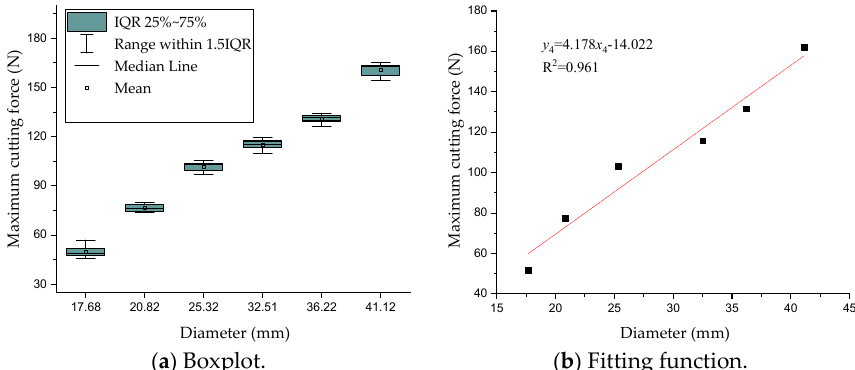
Figure 10. Boxplot and fitting function of transverse maximum cutting force of jujube bark.